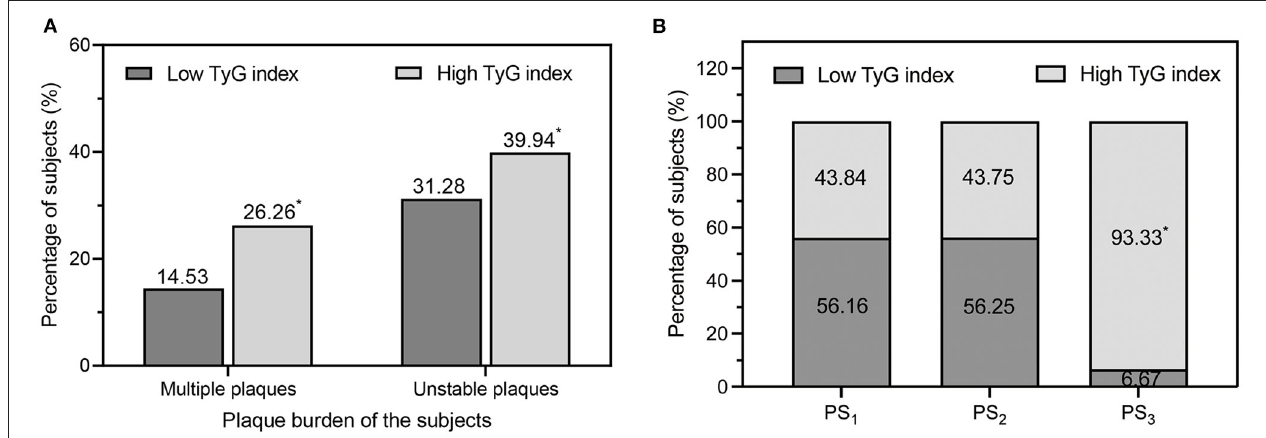
FIGURE 2 | (A) Comparison of the percentage of multiple plaques and unstable plaques in the low TyG index group and high TyG index group. (B) Percentages of low/high TyG index values in different categories of carotid plaque burden degree. PS 1 , low plaque burden; PS 2 , moderate plaque burden; PS 3 , high plaque burden. PS, plaque score; TyG, triglyceride-glucose. * P < 0.01 vs. low TyG index.